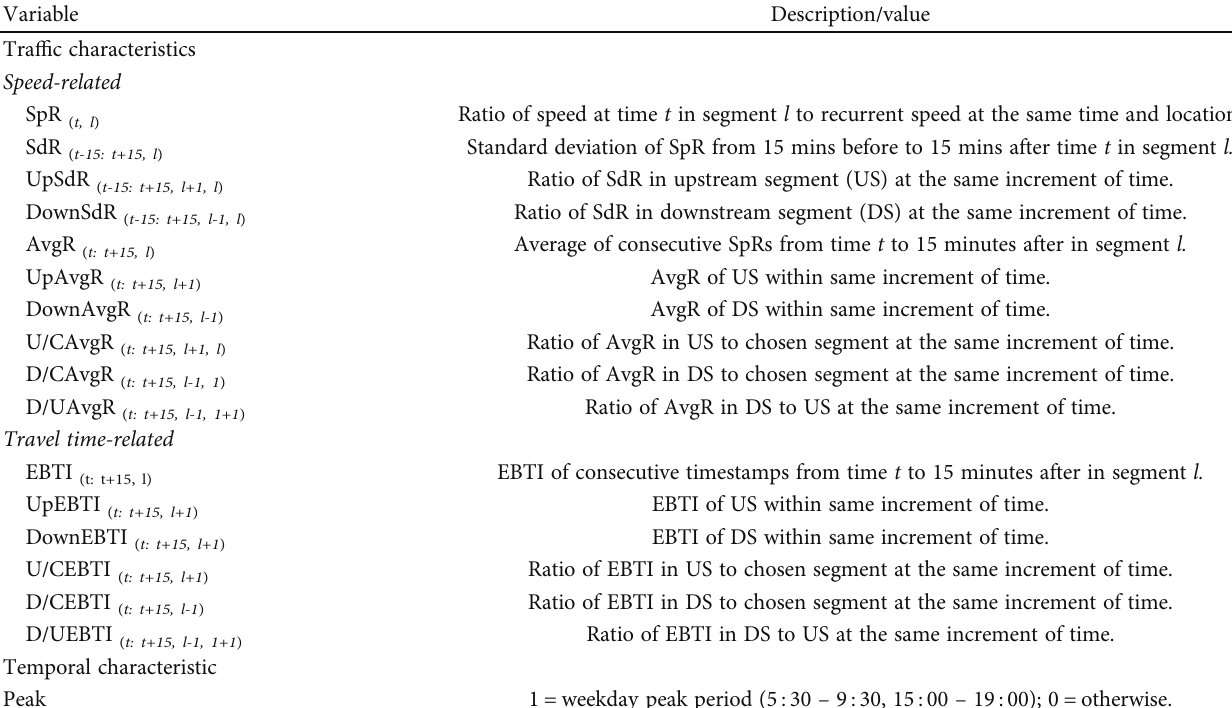
Table 4: Potential explanatory cariables (at 1-minute increment for a given TMC segment) and their de fi nitions.